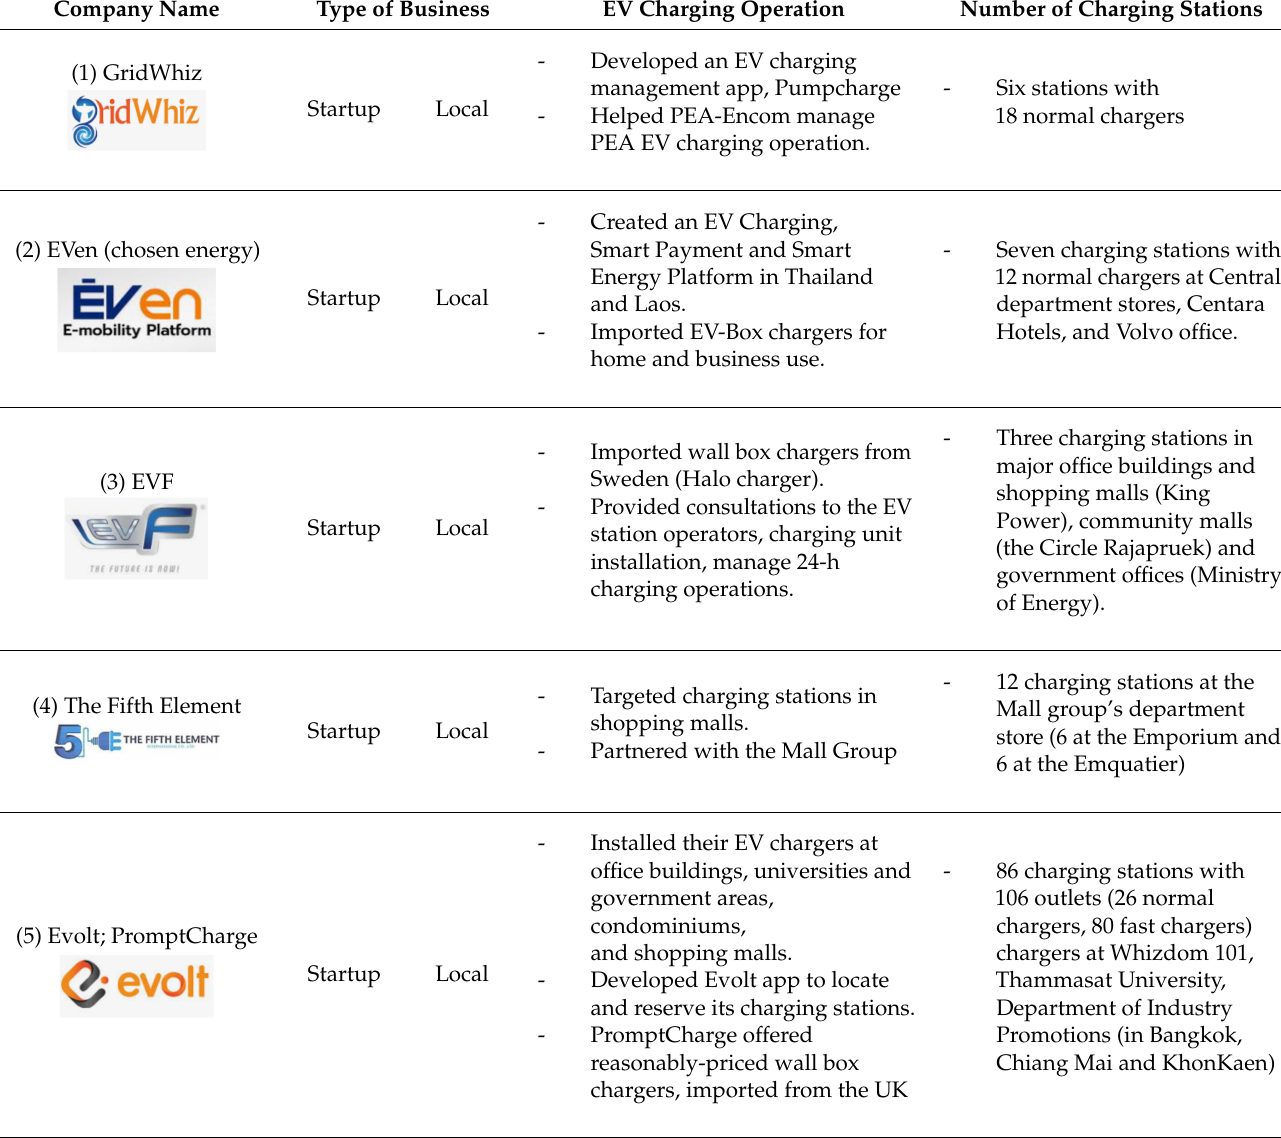
Table 7. EV charging operations of